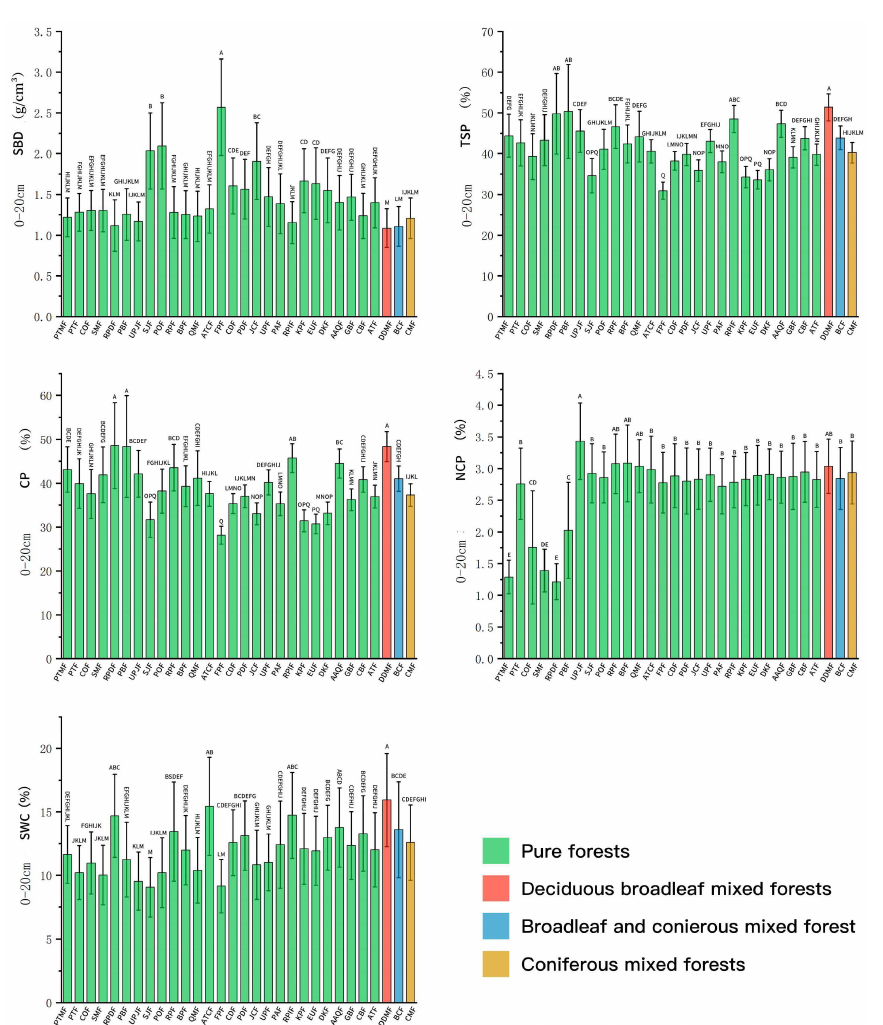
Figure 3. Multiple comparative analyses of the physical properties of soils in different communities. SWC: soil water content; CP: soil capillary porosity; SBD: soil bulk density; TSP: total soil porosity; NCP: noncapillary porosity. Note: Different lowercase letters indicate significant differences in the values of soil chemical properties between different community types ( p < 0.05). Abbreviations of community names refer to Table